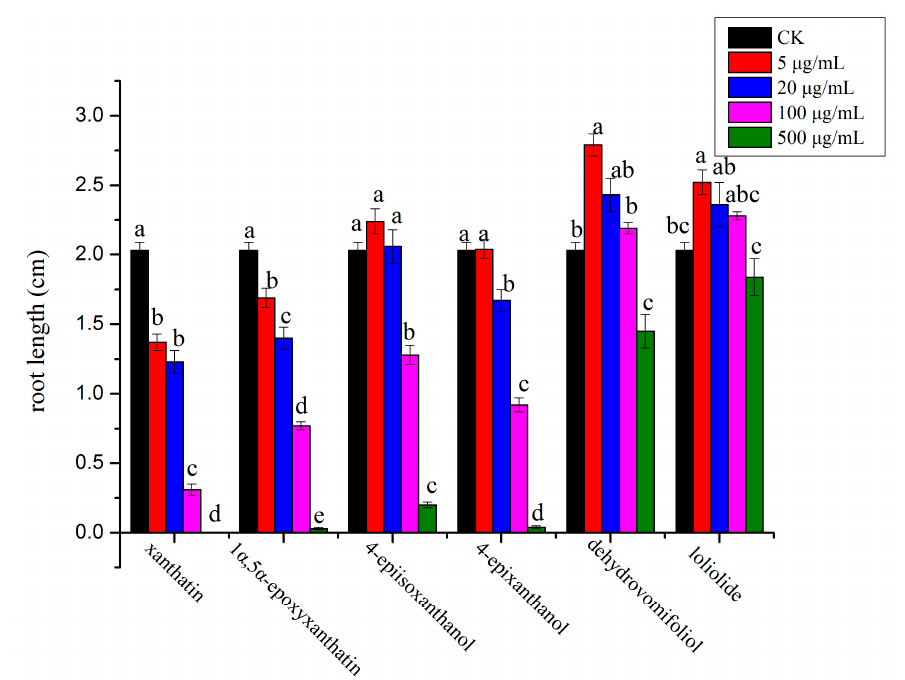
Figure 2. Phytotoxic effect of isolated compounds on root growth of A. retroflexus . Different letters represent a significant difference at p < 0.05 level according to Fisher’s LSD test.